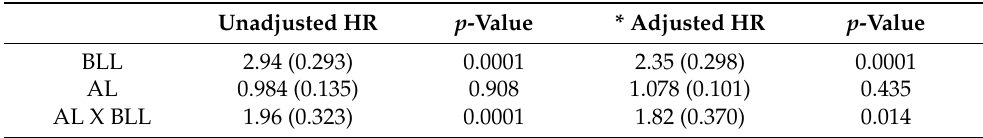
Table 3. Cardiovascular mortality risk in adults exposed to Pb and